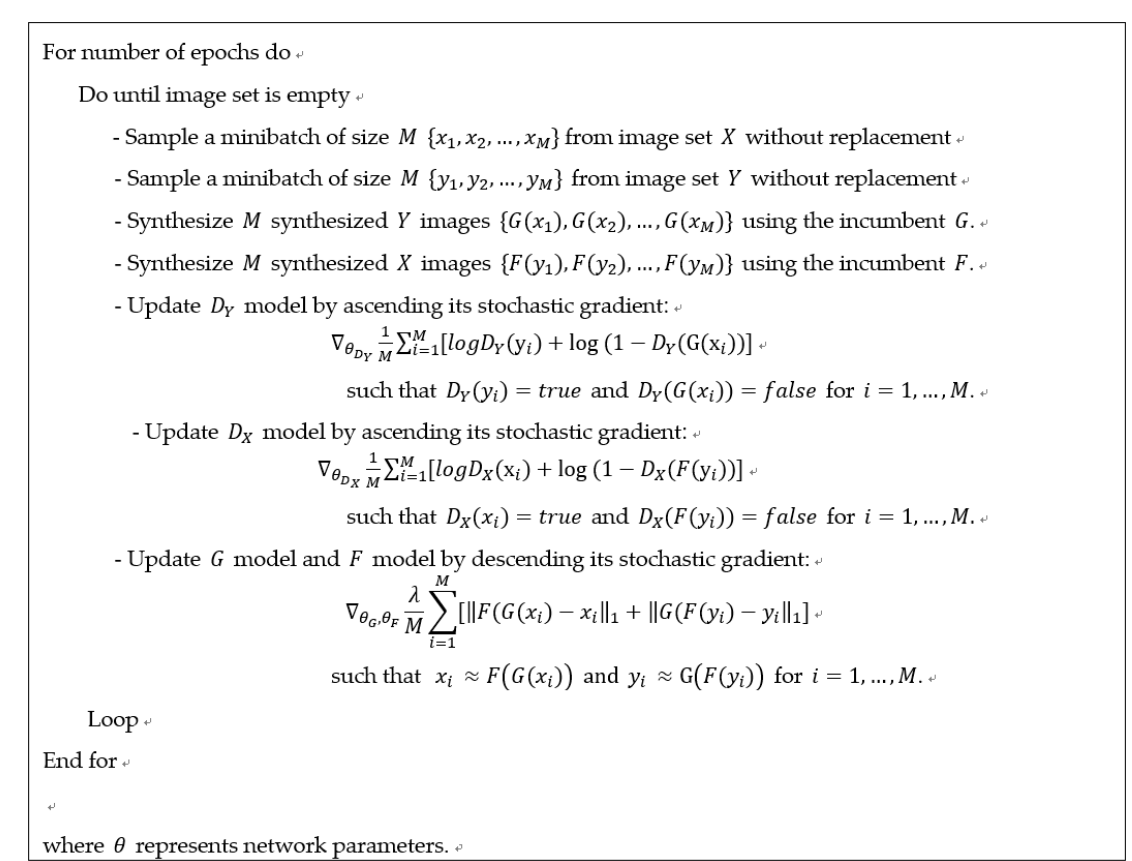
Figure 9. Solution algorithm for CycleGAN.